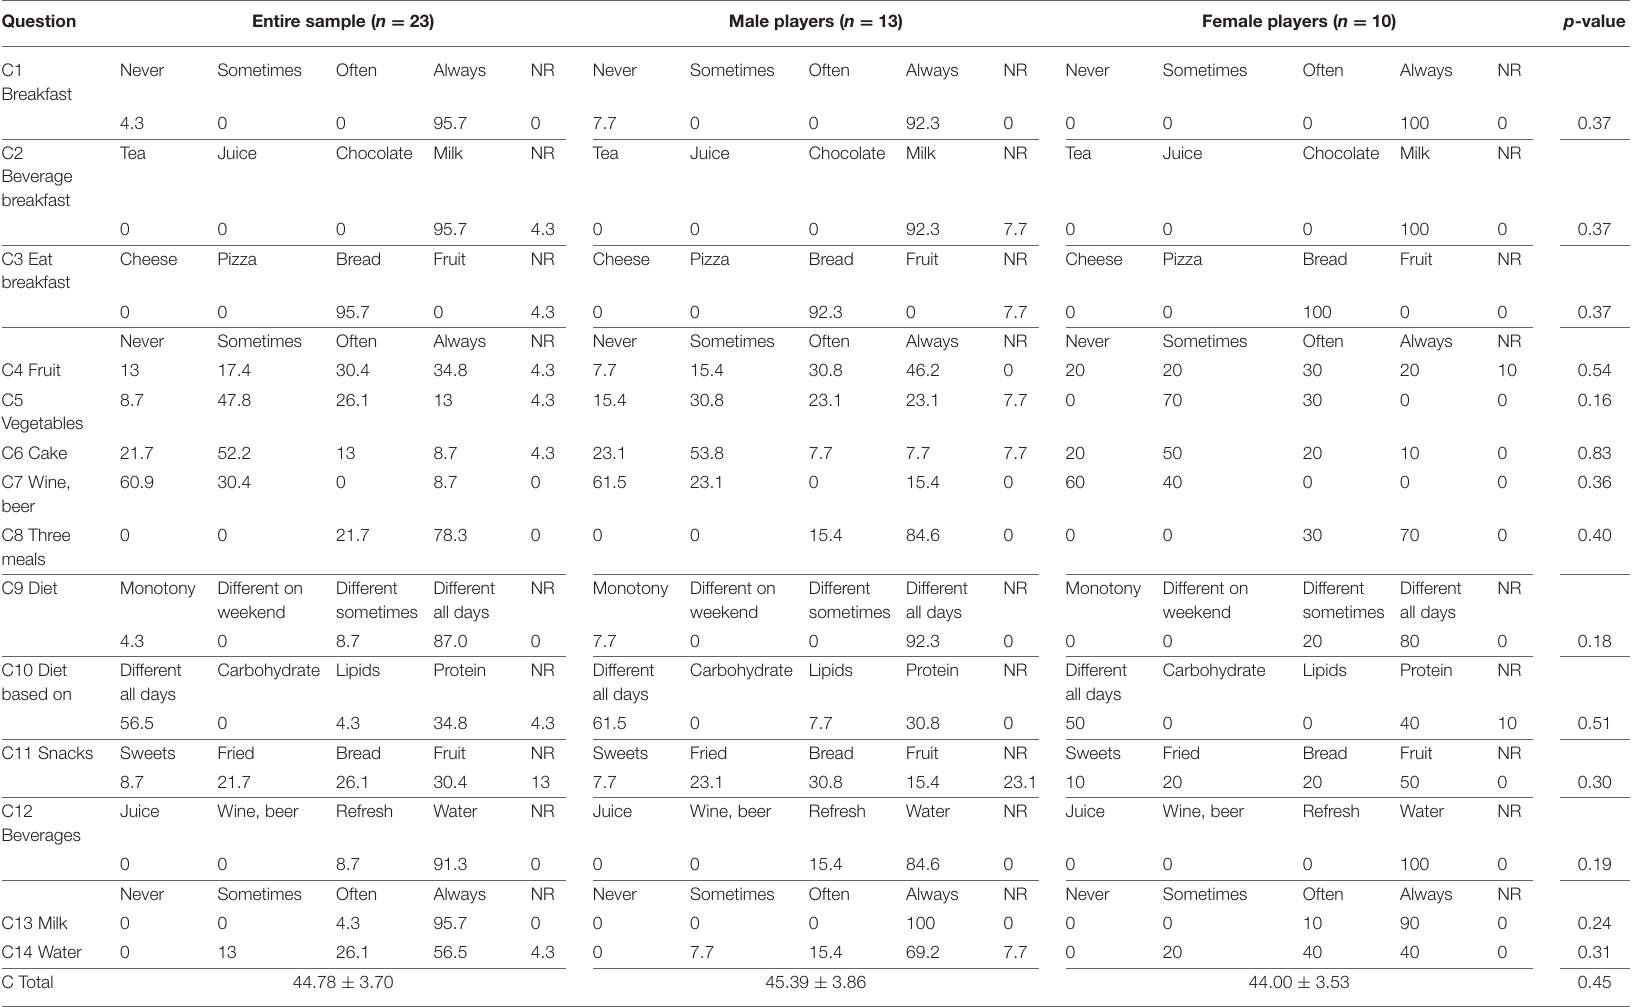
TABLE 3 | Comparisons in nutritional habits between elite, male, and female, U-14 basketball